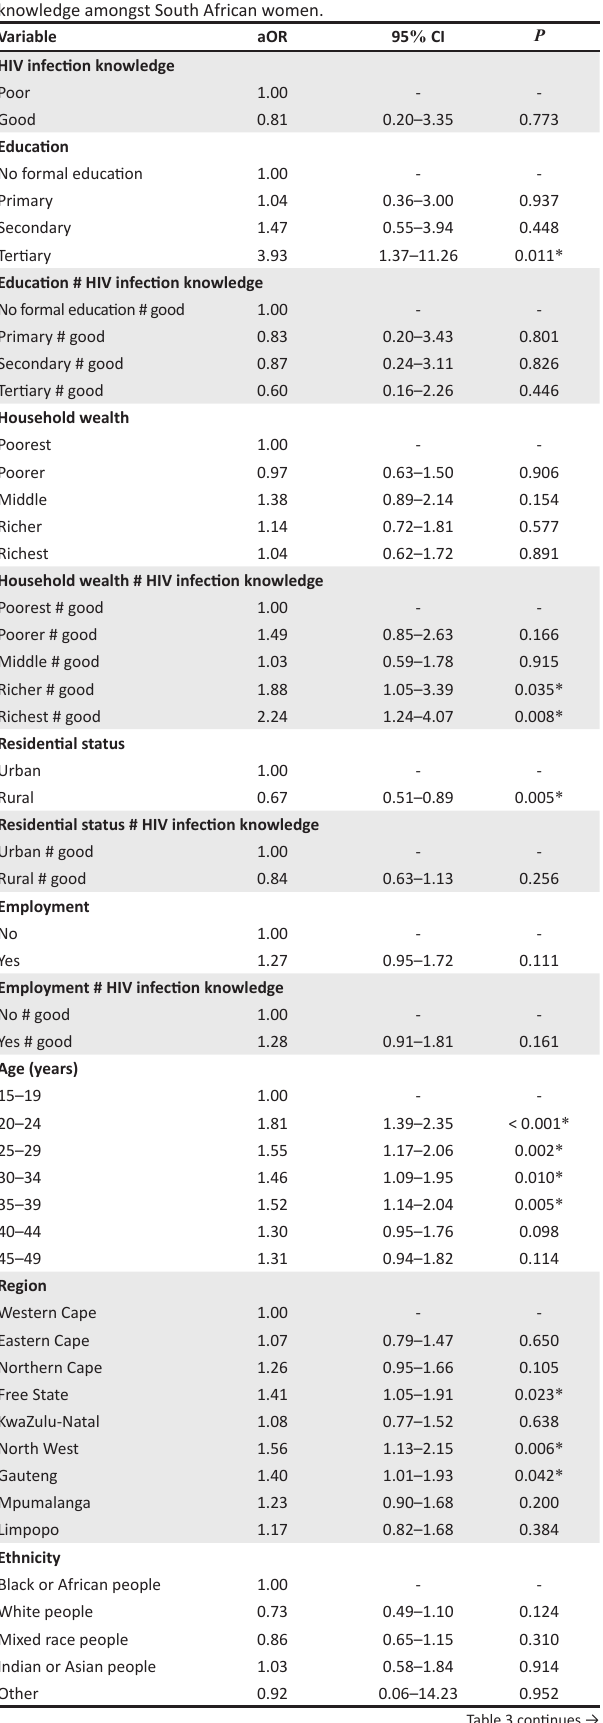
TABLE 3: Measures of the association of factors linked to HIV self-testing knowledge amongst South African women. Variable aOR